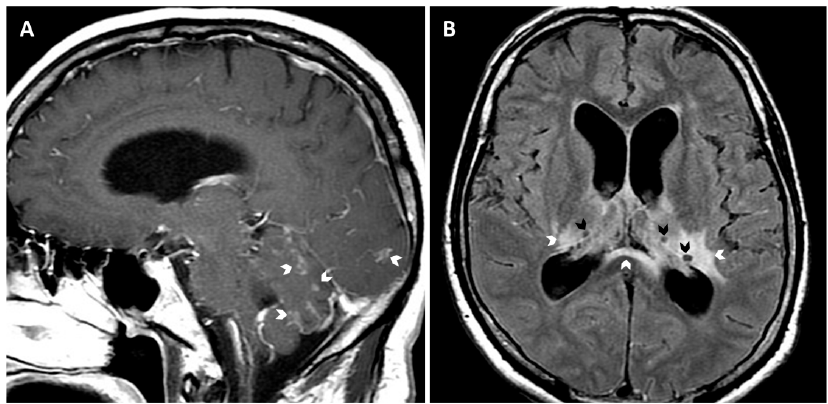
Figure 1. Brain MRI images ( A , sagittal T1Gd and B , axial T2-FLAIR [fluid attenuated inversion recovery] showing generalized leptomeningeal enhancement (arrows in A ), ganglionar and periventricular edema (white arrows in B ), cystic lesions suggestive of gelatinous pseudocysts (black arrows in B ), and enlarged ventricles compatible with communicating hydrocephalus.